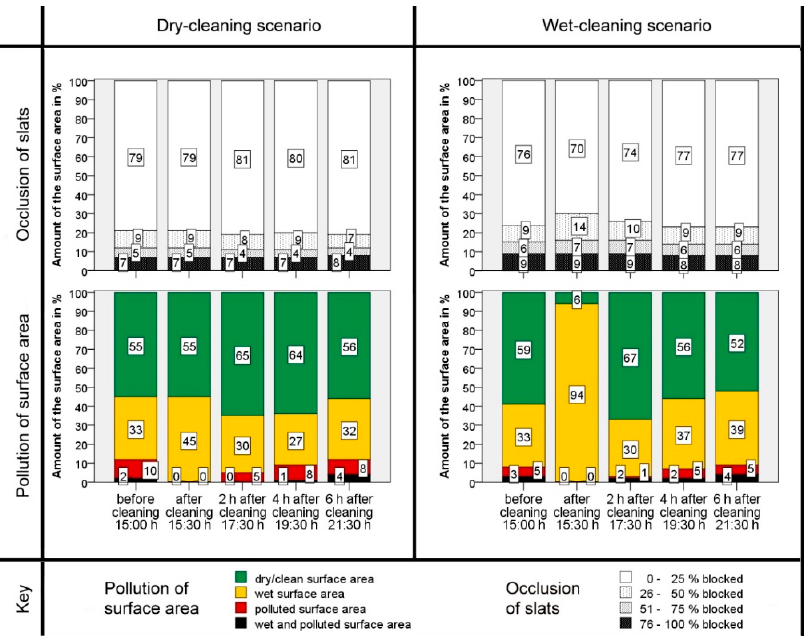
Figure 6. Results of the cleaning performance of the robot scraper before cleaning and at different intervals after cleaning for the cleaning runs in the afternoon (Start: 15:00 h): Proportion of occluded slots (above) and degree of polluted surface area (below) for both cleaning scenarios, dry-cleaning (left) and cleaning with the use of water (right). The numbers in the bars indicate the respective percentage of the total floor area of the experimental compartment.